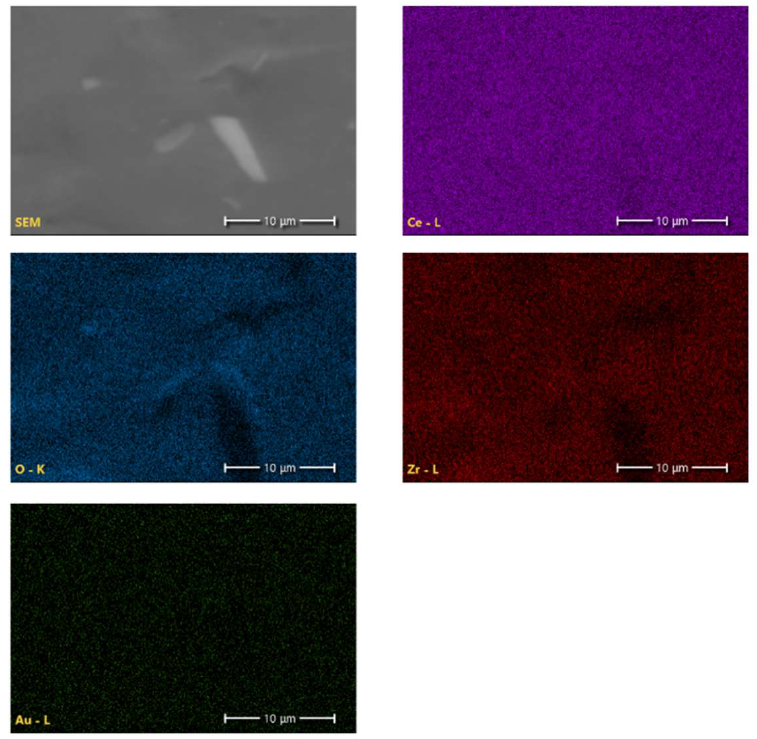
Figure 8. Elemental maps of cerium, oxygen, zirconium and gold in Au/Zr 0.93 Ce 0.07 O 2.